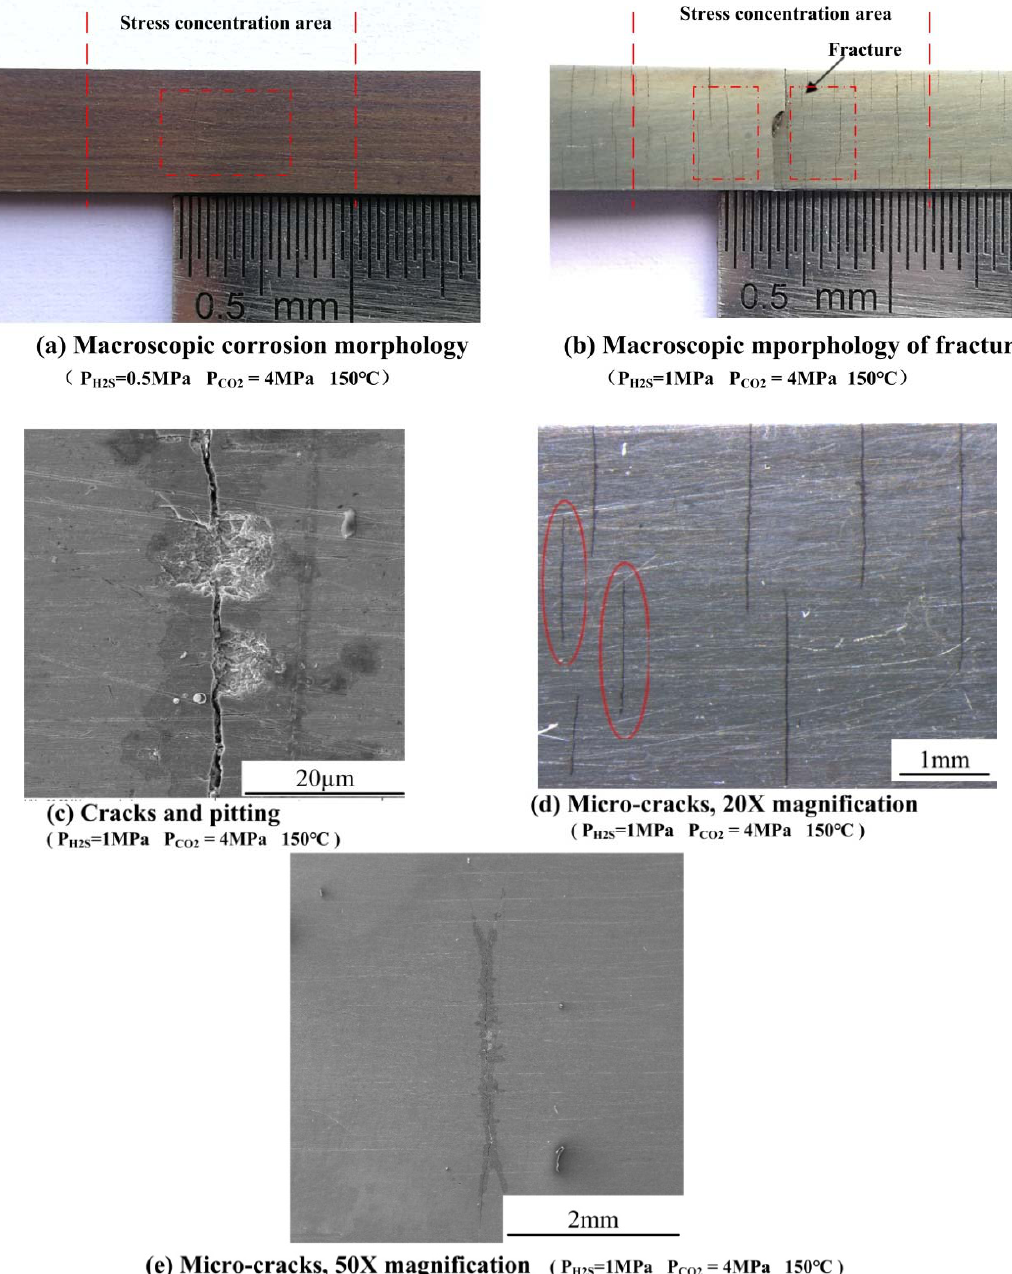
Figure 4. The surface corrosion morphology of the samples under the applied stress at 150 ◦ C: ( a ) Macro-corrosion morphology of stress concentration surface, ( b ) Macro-corrosion morphology of fracture area, ( c ) Micro-morphology of crack and pitting in the stress concentration region, ( d ) Micro-cracks morphology originating from the center of the sample in the stress concentration region (20 × magnification), and ( e ) Micro-crack morphology under 50 × magnification.